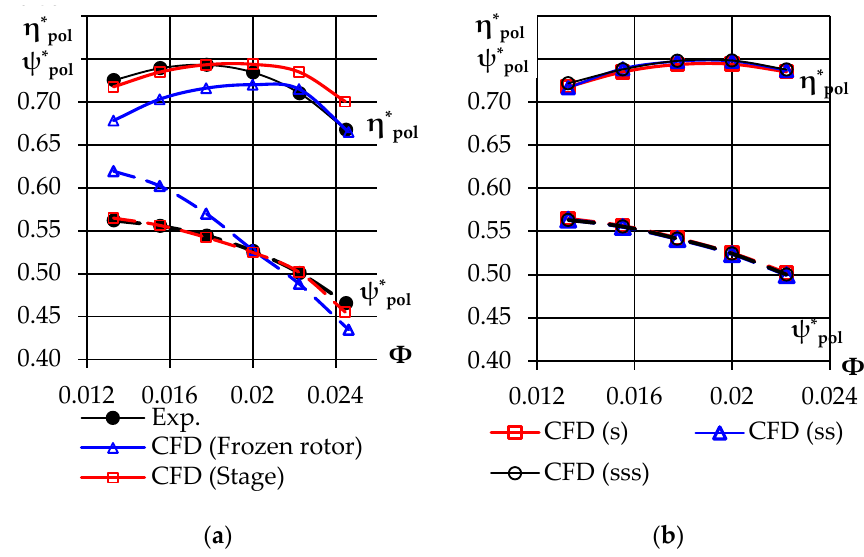
Figure 3. Results of the intergrid interface study on the results of modeling the Q-482 model stage ( a ) interface type; ( b ) interface downstream location. s—stage interface after impeller only, ss—stage interface after impeller and vaneless diffuser, sss—stage at all intersectional interfaces.